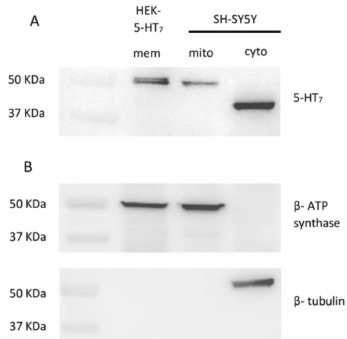
Figure 1. ( A ) Expression of 5-HT7R in cytosolic (cyto) and mitochondrial (mito) enriched fractions obtained from SH-SY5Y cell line. Positive control represented by membranes (mem) obtained from 5-HT7R-stably transfected HEK 293 cells. ( B ) Same fractions of SH-SY5Y analyzed to detect β -ATP synthase (mitochondria marker) and β -tubulin (cytosol marker) expression by sequential reprobing on same blot. Molecular mass markers (KDa) indicated on the